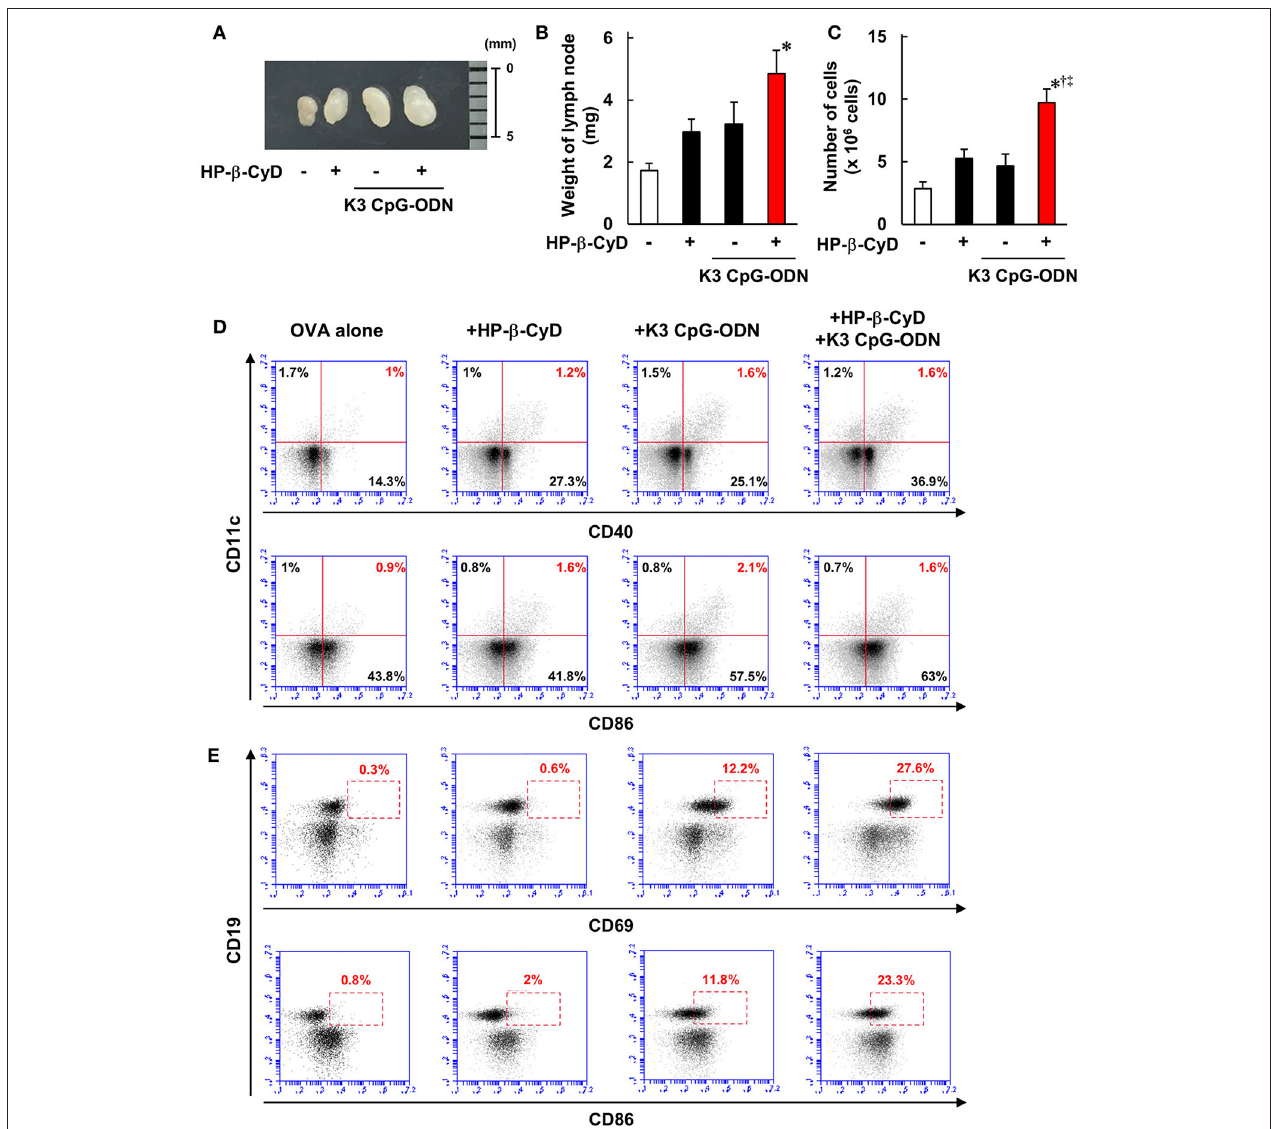
FIGURE 5 | HP- β -CyD and K3 CpG-ODN cooperatively enhance the immune response in the draining lymph node. (A–E) C57BL/6 mice were inoculated with 3 µ g of OVA solution containing 30% HP- β -CyD and 10 µ g of K3 CpG-ODN into the base of the tail. The draining lymph node was collected after 24h. After taking a photograph, the weight of lymph node and the number of lymphocytes was measured. (B,C) Each value represents the mean ± S.E. ( n = 6 per group in two independent experiments). * p < 0.05 compared with OVA alone, † p < 0.05 compared with OVA + HP-b-CyD, ‡ p < 0.05 compared with OVA + K3 CpG-ODN (one-way ANOVA with Bonferroni’s multiple comparison test). (D,E) The expression of CD40, CD69, and CD86 on CD11c + or CD19 + cells was analyzed by flow cytometry. The experiments were performed independently three times, and representative data are